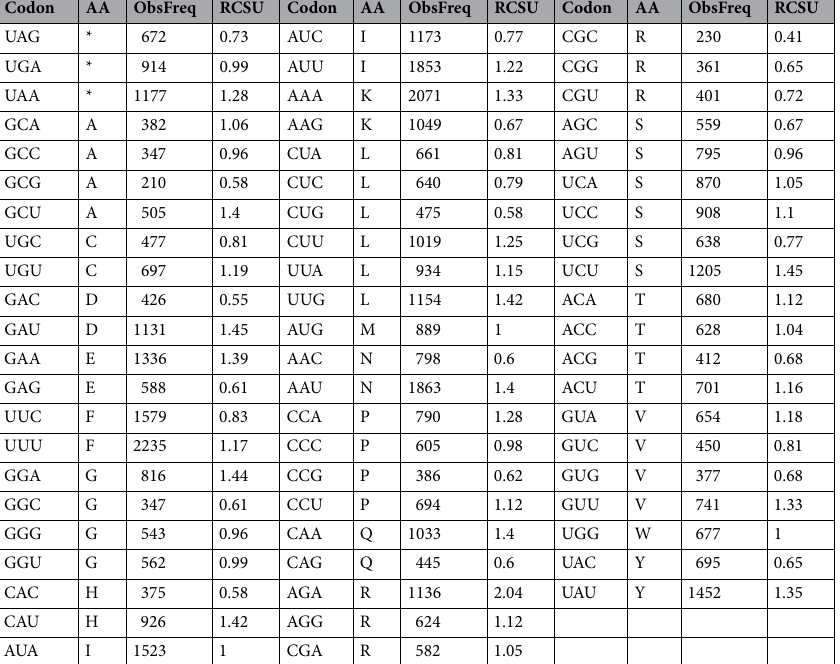
Table 3. Relative synonymous codon usage (RSCU) for protein-coding genes in A. megaphylla Hu. *stop